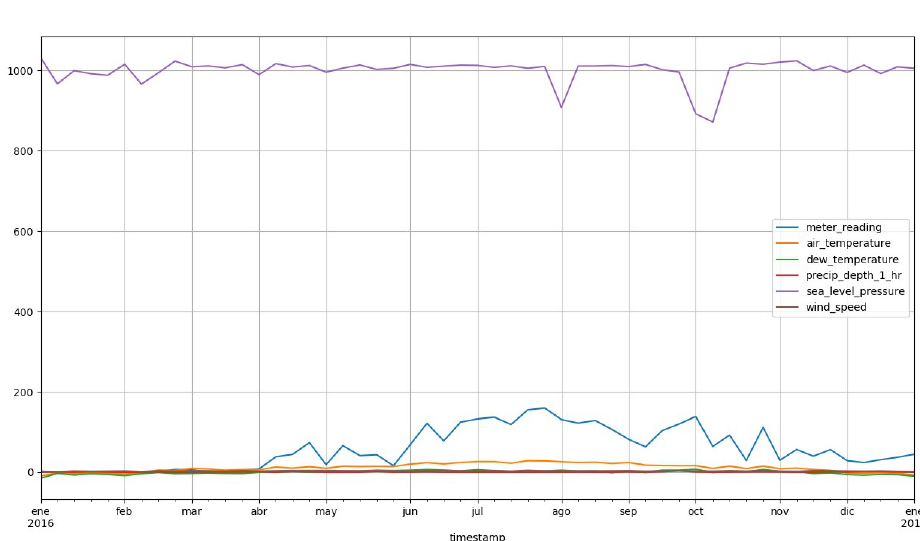
Figure 7. Evolution of time series over time for selected